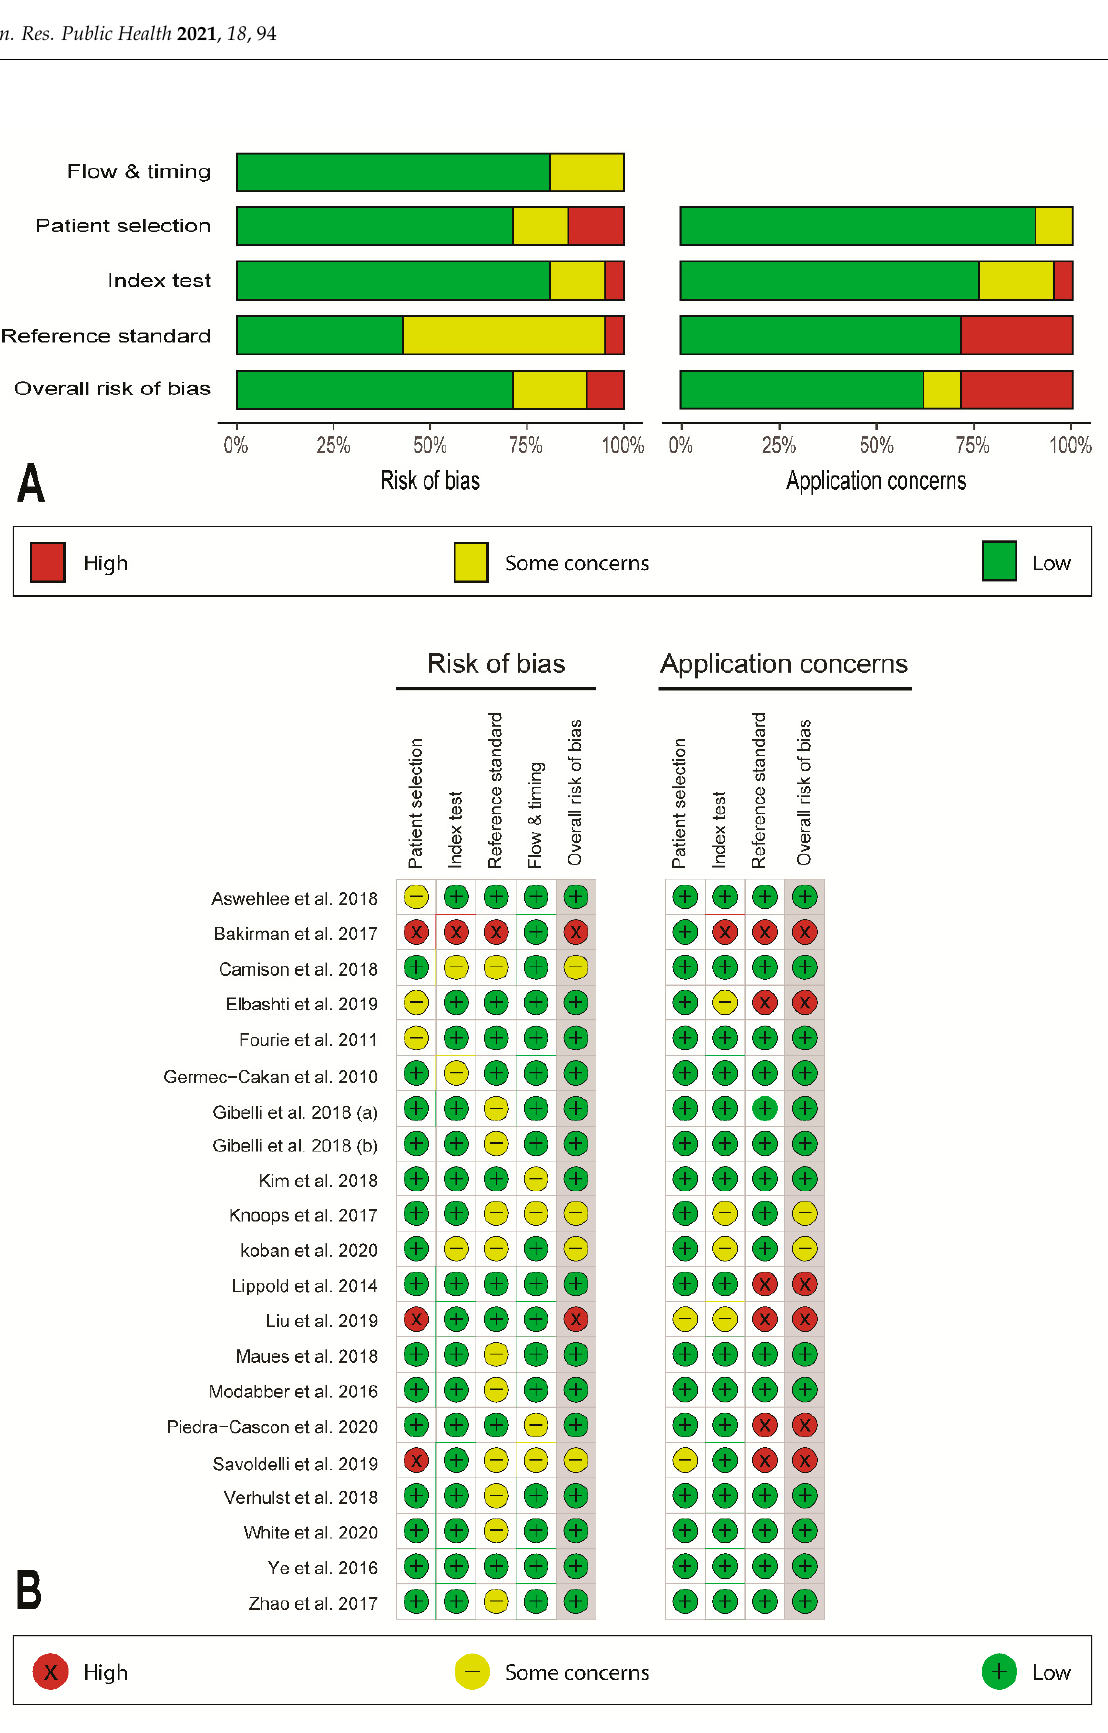
Figure 2. Risk of bias and application concerns according to the QUADAS-2 guidelines. ( A ) Weighted bar-chart; ( B ) traffic light plots.